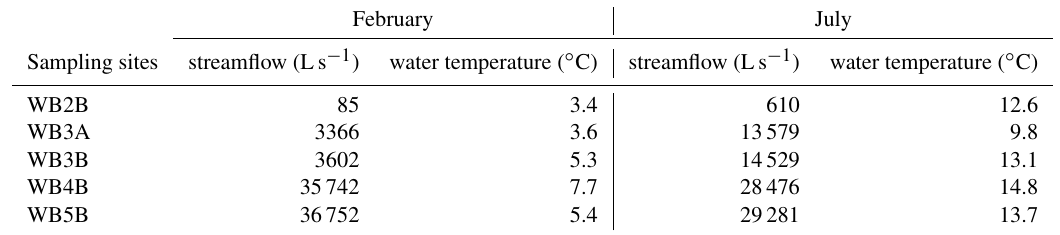
Figure 2. Map of the Adige River basin and its main tributaries with a zoom on the Noce River basin (upper left panel). Green triangles represent the main WWTPs, whereas red stars indicate the gauging stations. The gauging stations used as control sections are identified with their names (i.e., Soraga, Vermiglio, Ponte Adige, and Bronzolo). Only for the Noce basin do yellow diamonds show the sampled locations during the two sampling campaigns of February and July 2015. Table 2. Streamflow (Ls − 1 ) and water temperature ( ◦ C) data of the five selected sampling sites during the two sampling